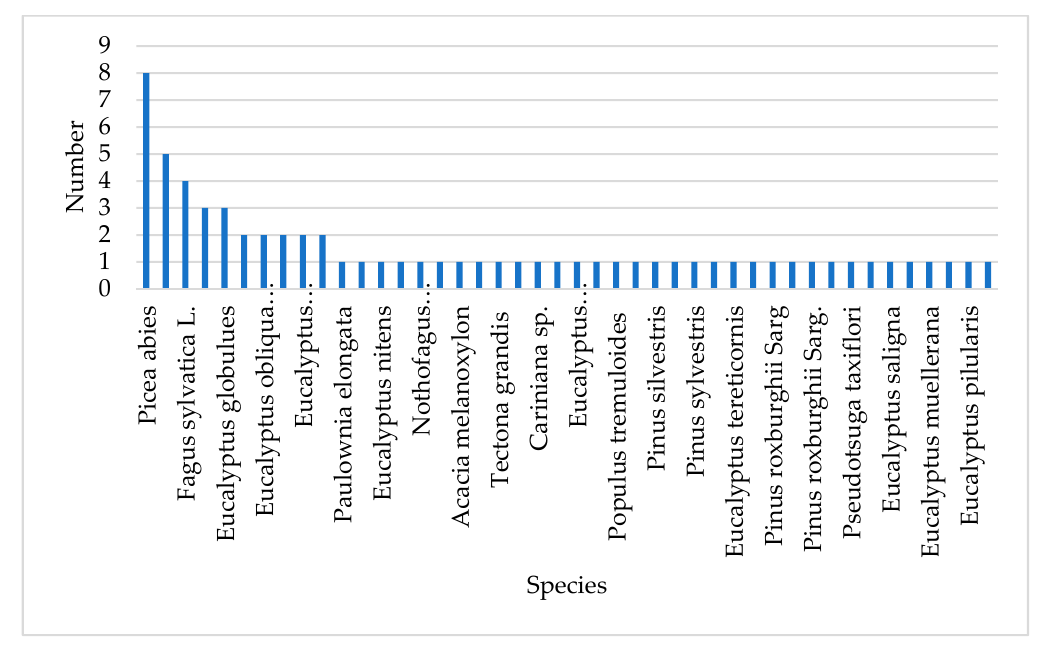
Figure 10. Used wood species. With respect to the most used genus of wood, Eucalyptus was the first (29.85%), followed by Pinus (17.91%), and then by Picea (14.93%), as shown in Figure 11.